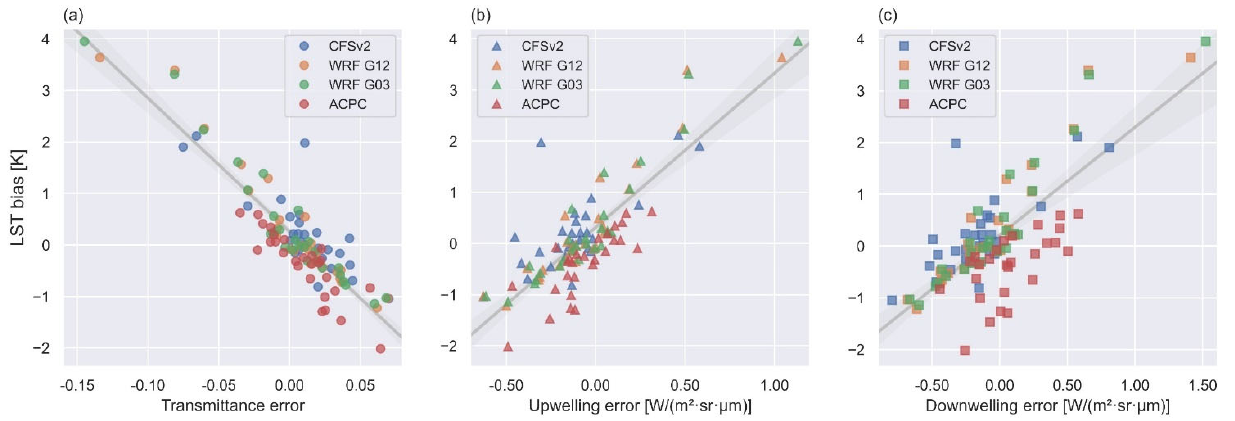
Figure 9. Relation of daily LST bias with errors in ( a ) transmittance, ( b ) upwelling, and ( c ) downwelling radiances for each case day. The gray line represents the linear regression for all data.